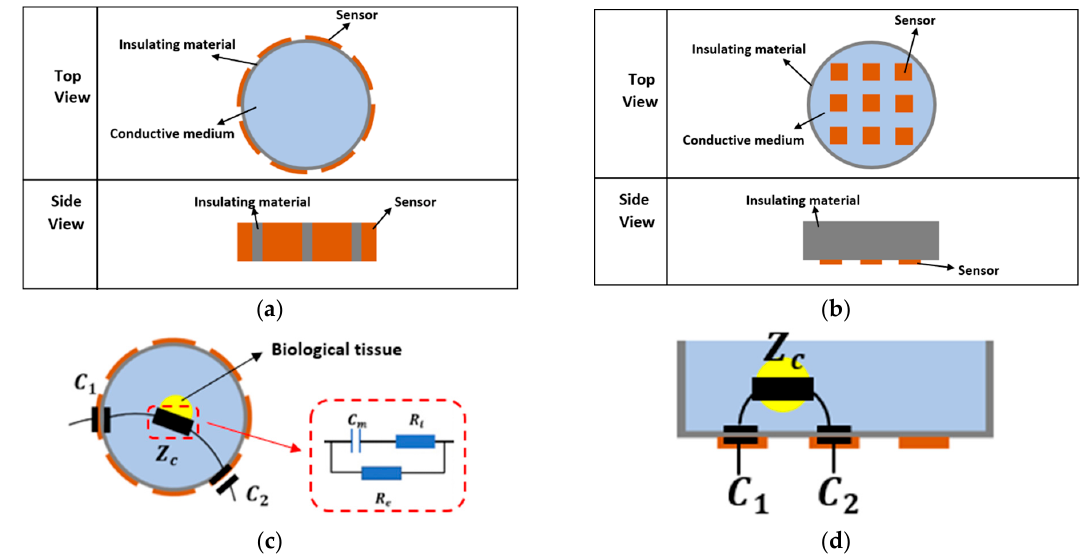
Figure 4. ( a ) Circular array. ( b ) Planar array. ( c ) Equivalent Circuit of circular CCERT with bio-tissue inside. ( d ) Equivalent Circuit of planar CCERT with bio-tissue inside.